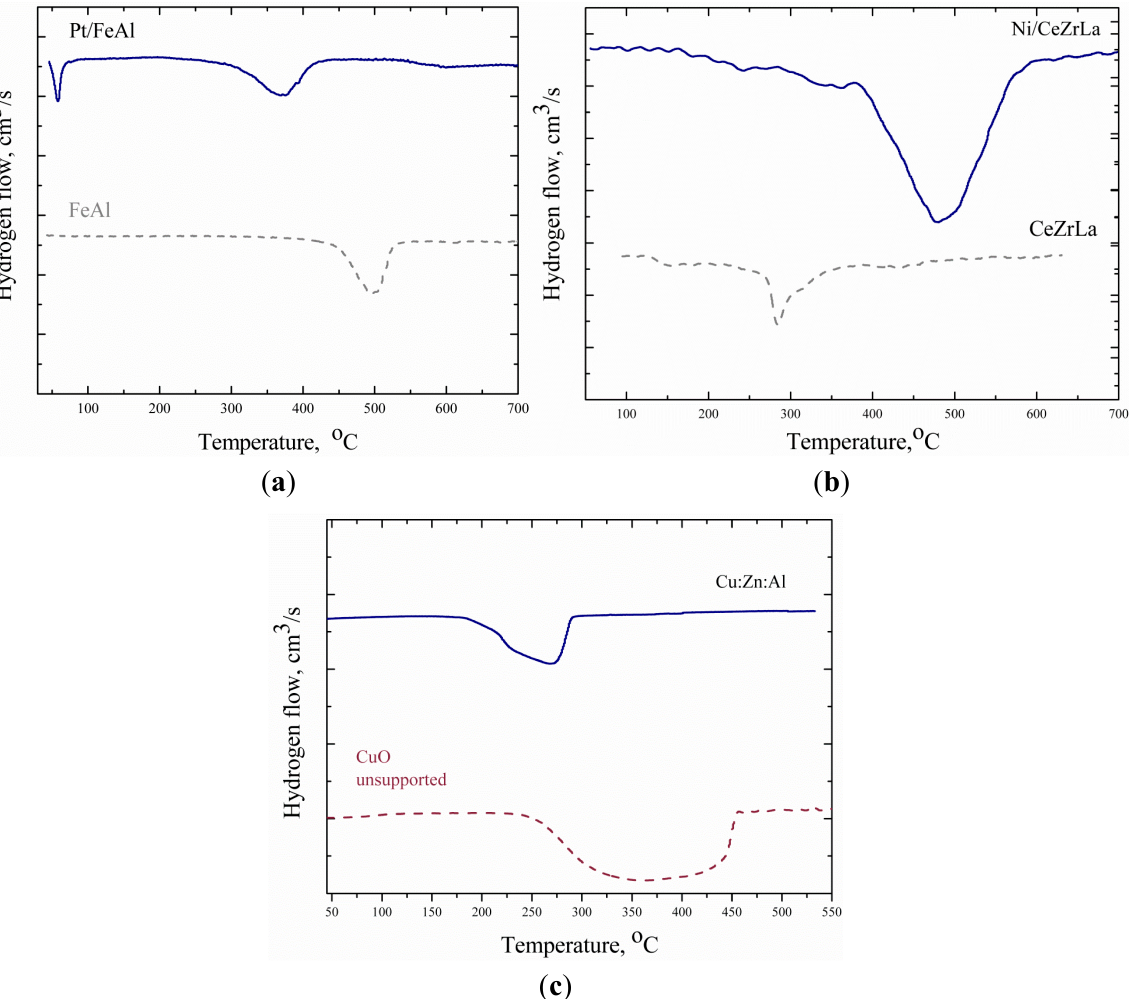
Figure 2. Reduction profiles of: ( a ) FeAl support, Pt/FeAl; ( b ) CeZrLa support, Ni/CeZrLa; and ( c ) CuO unsupported and